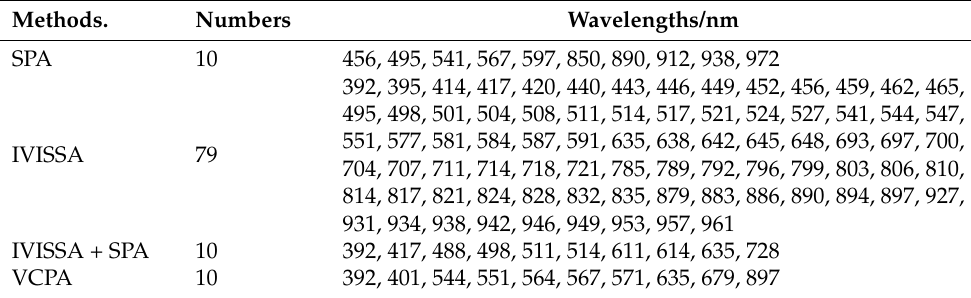
Table 3. Statistical table of characteristic wavelength selection.